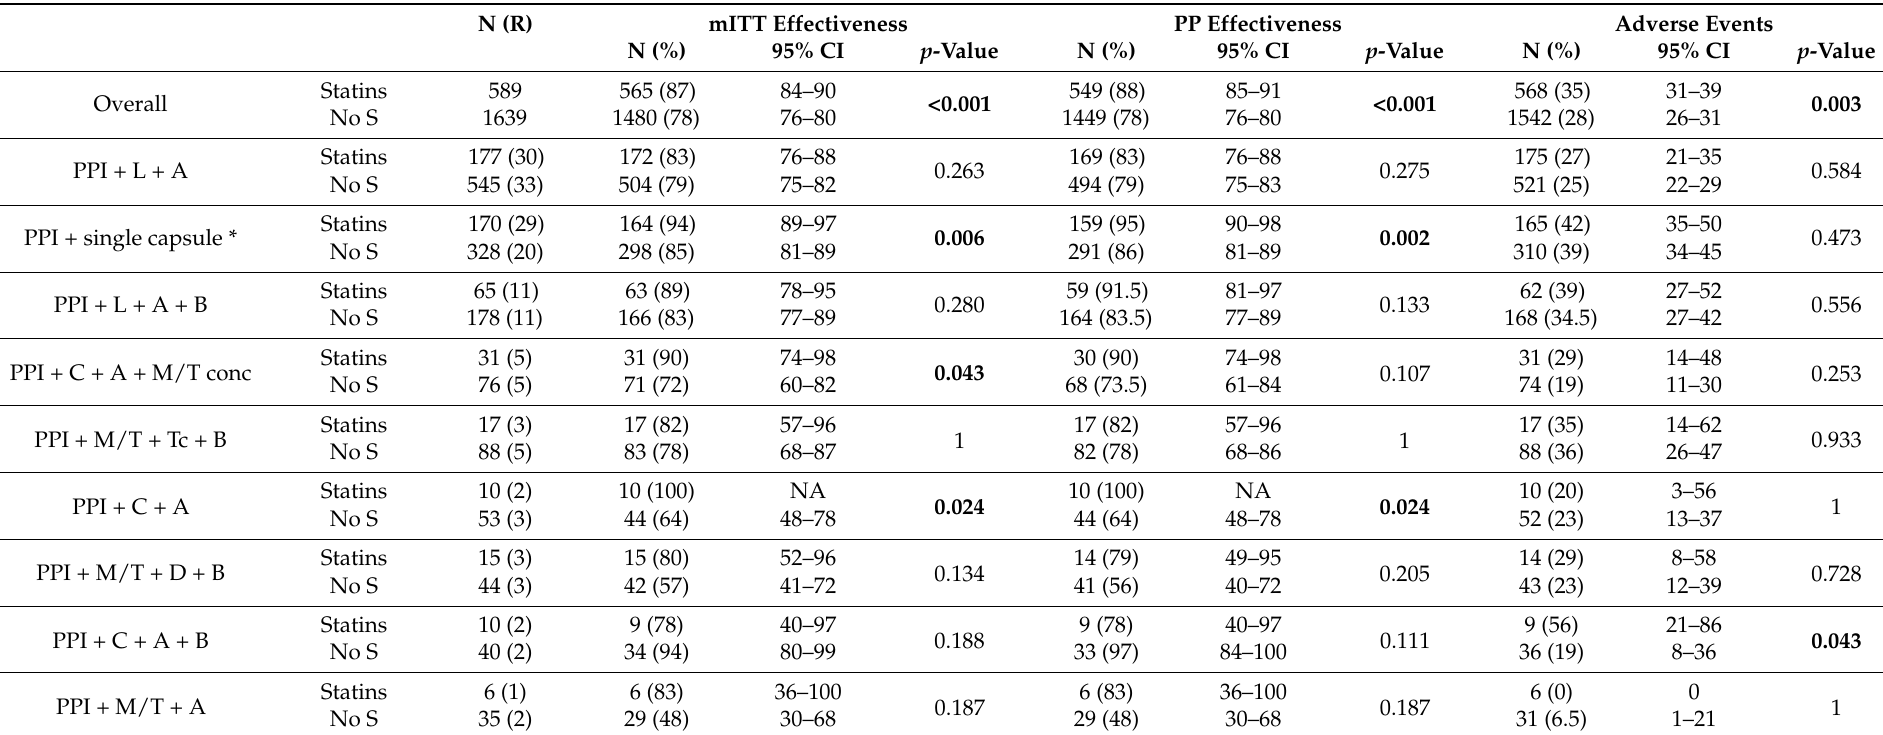
Table 7. Effectiveness and safety in rescue lines empirically prescribed therapies: 2nd–6th